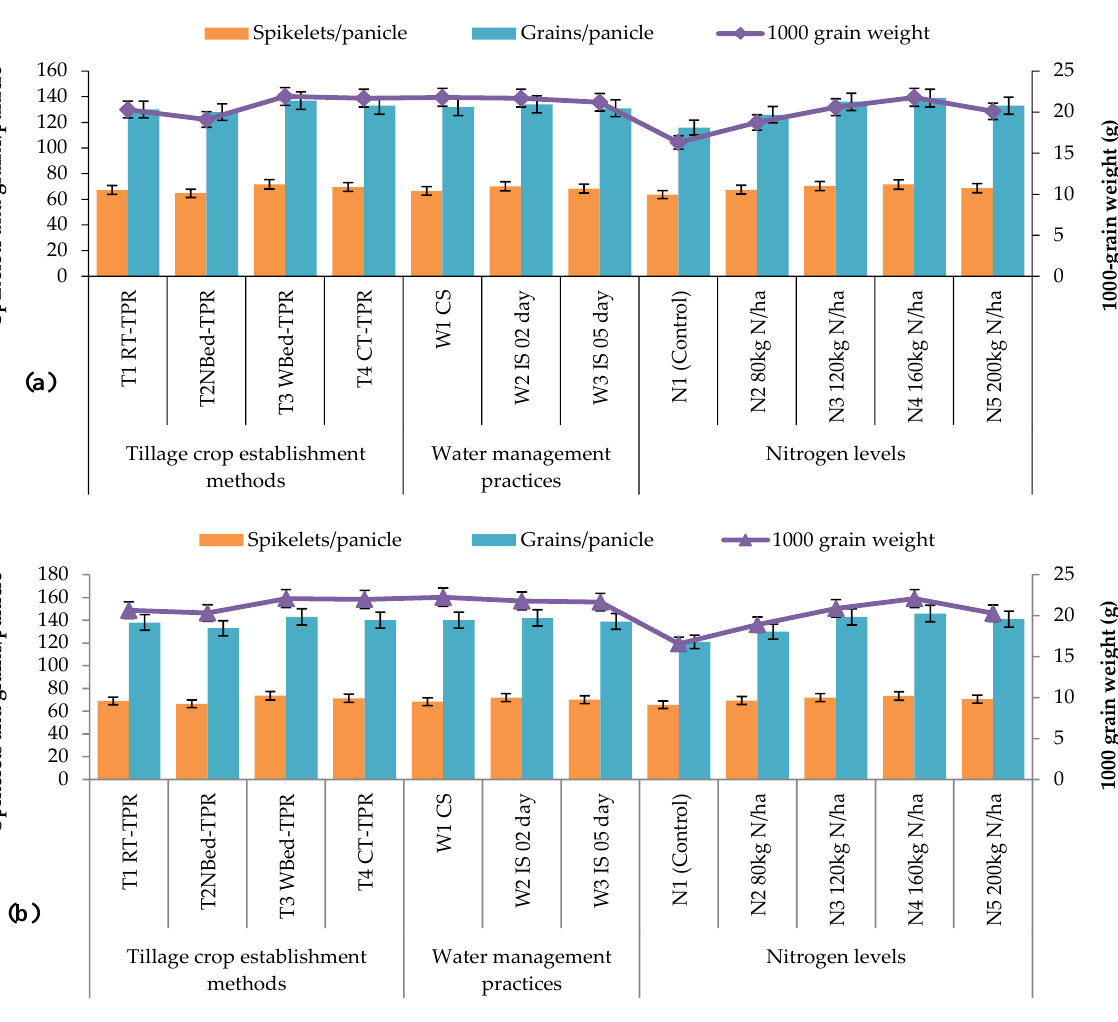
Figure 5. Interactive effects of tillage, water and nitrogen on spikelets and grains/panicle and 1000 grain weight of rice in both years: ( a ) 2016 and, ( b )